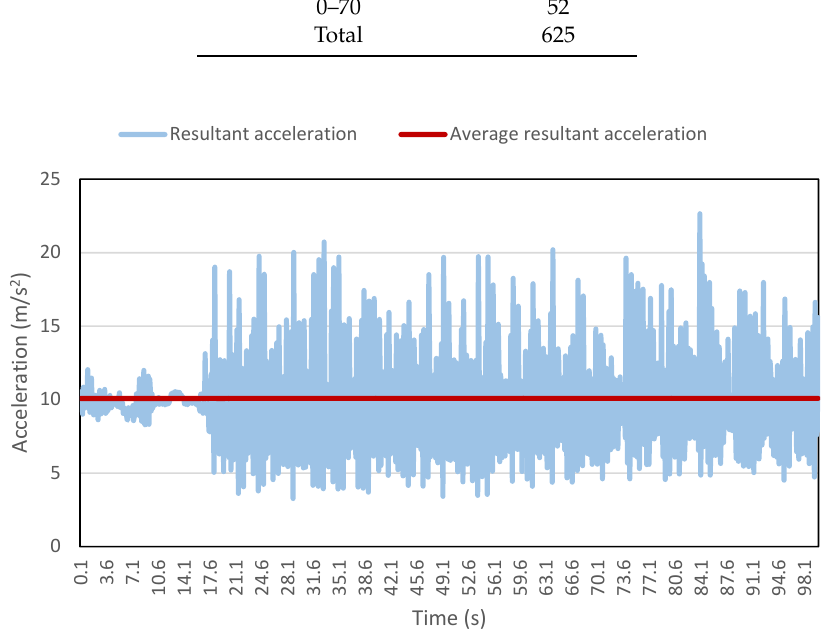
Figure 12. Resultant acceleration and average resultant acceleration for part of a walking trip.